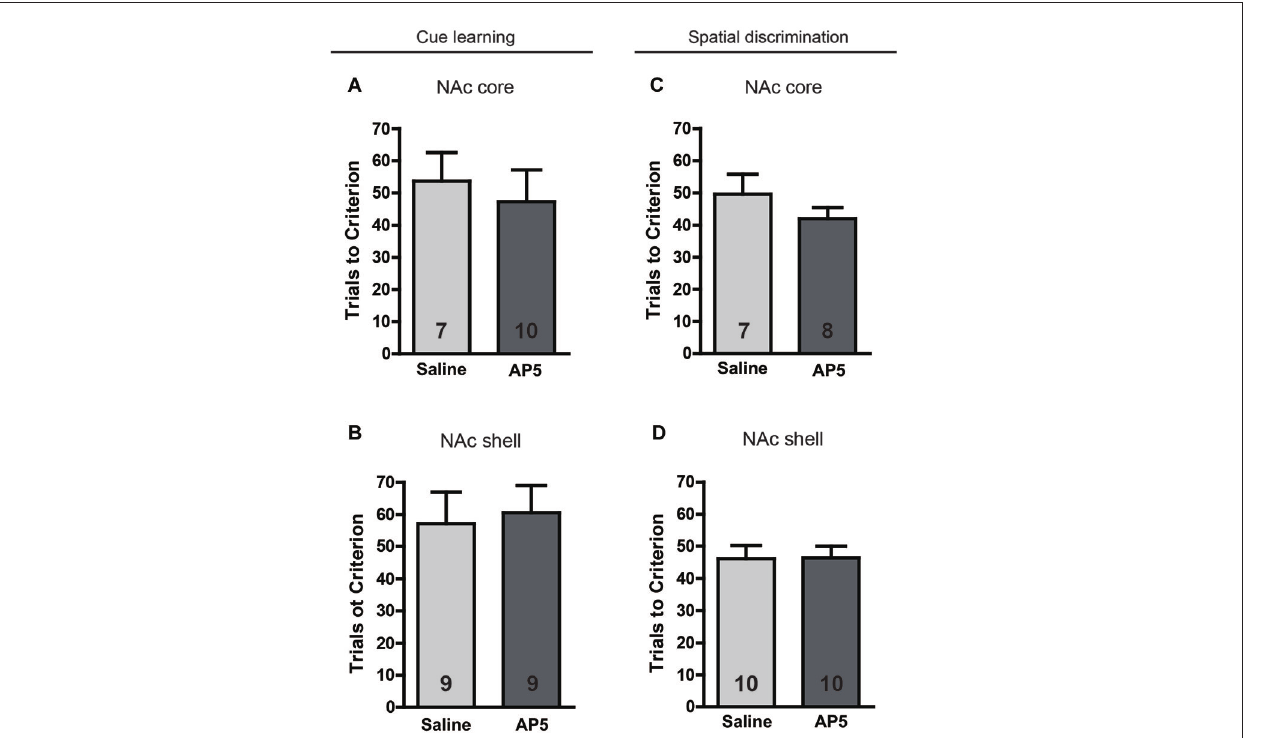
between a visual cue and reinforcement or between a spatial response and reinforcement. Before the behavioral test, 0.5 µ g (0.5 µ l) of an AP5 solution or saline vehicle was infused into the NAc core or shell per side. The sample size in each group is shown in the corresponding column.